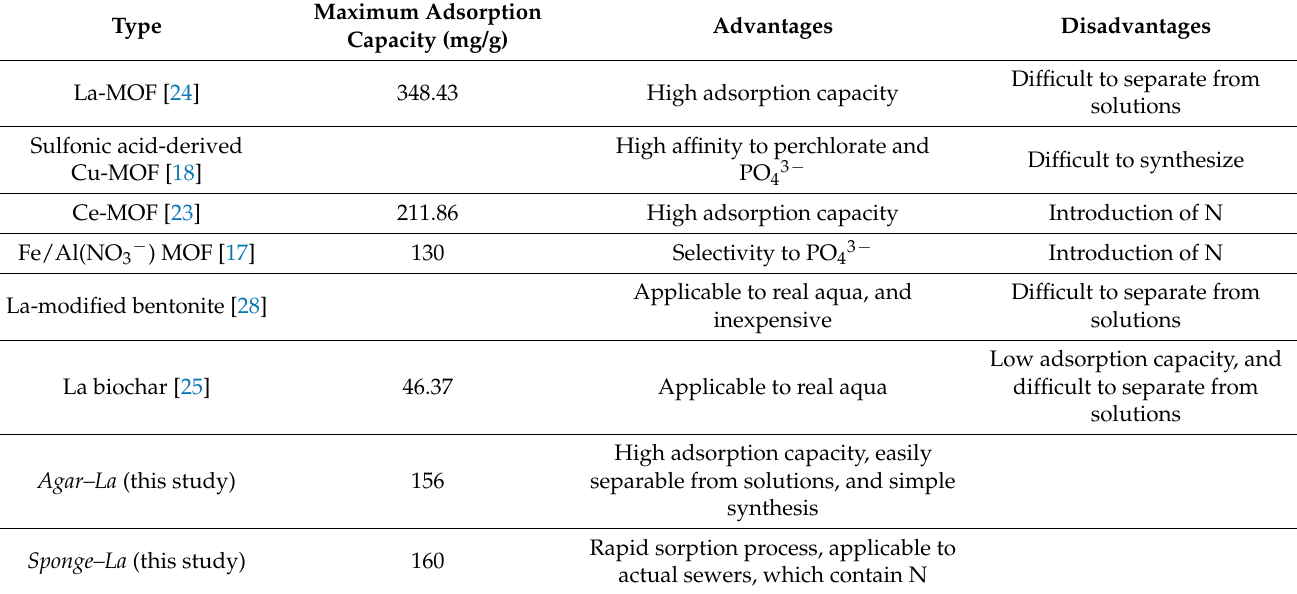
Table 1. Comparison of other